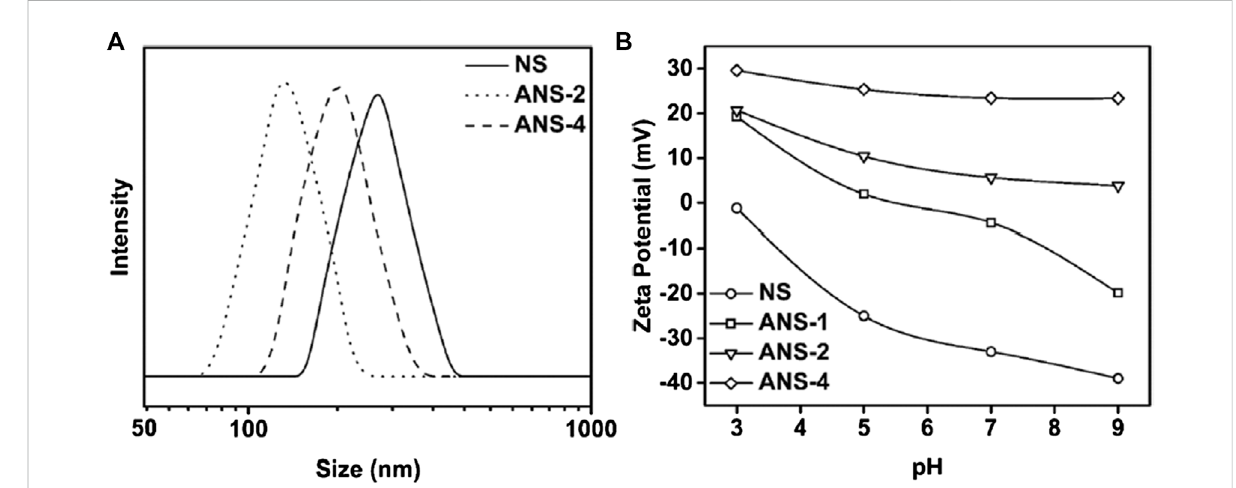
FIGURE 5 (A) Size of untreated (NS) and APTES-treated nanoparticles; (B) dependence of zeta potential on pH for nanoparticles of varying APTES treatment (Cao et al., 2018b).